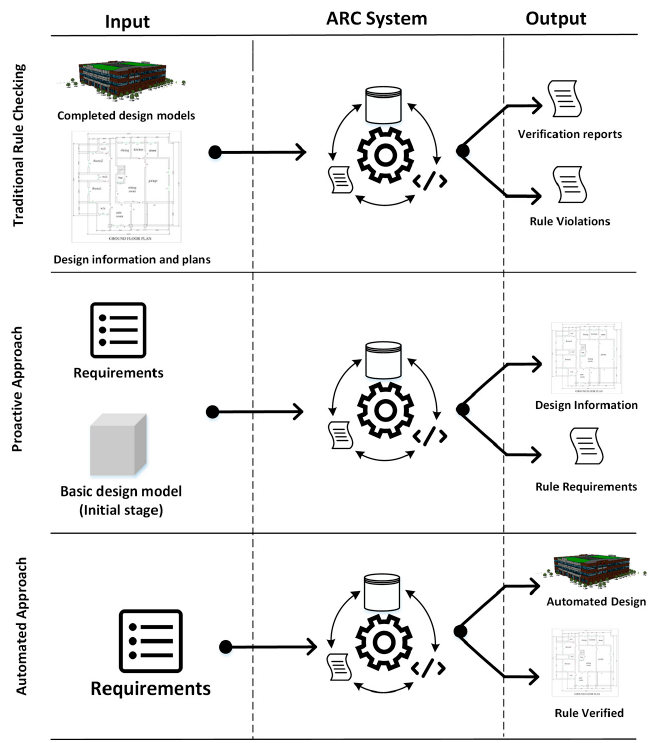
Figure 8. Three perspectives on the role of ARC in AEC applications.